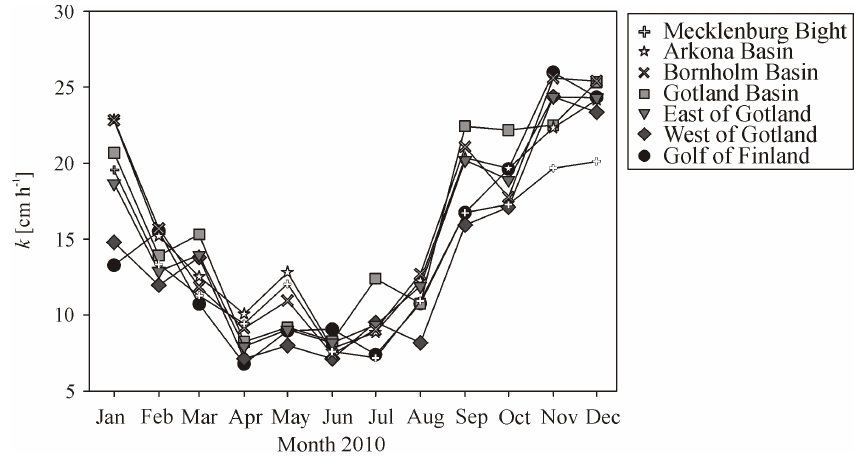
Fig. 9. Transfer coefficient k during 2010 for selected areas of the Baltic Sea with k = 0 . 24 · u 2 after Wanninkhof et al. (2009); whereas u is